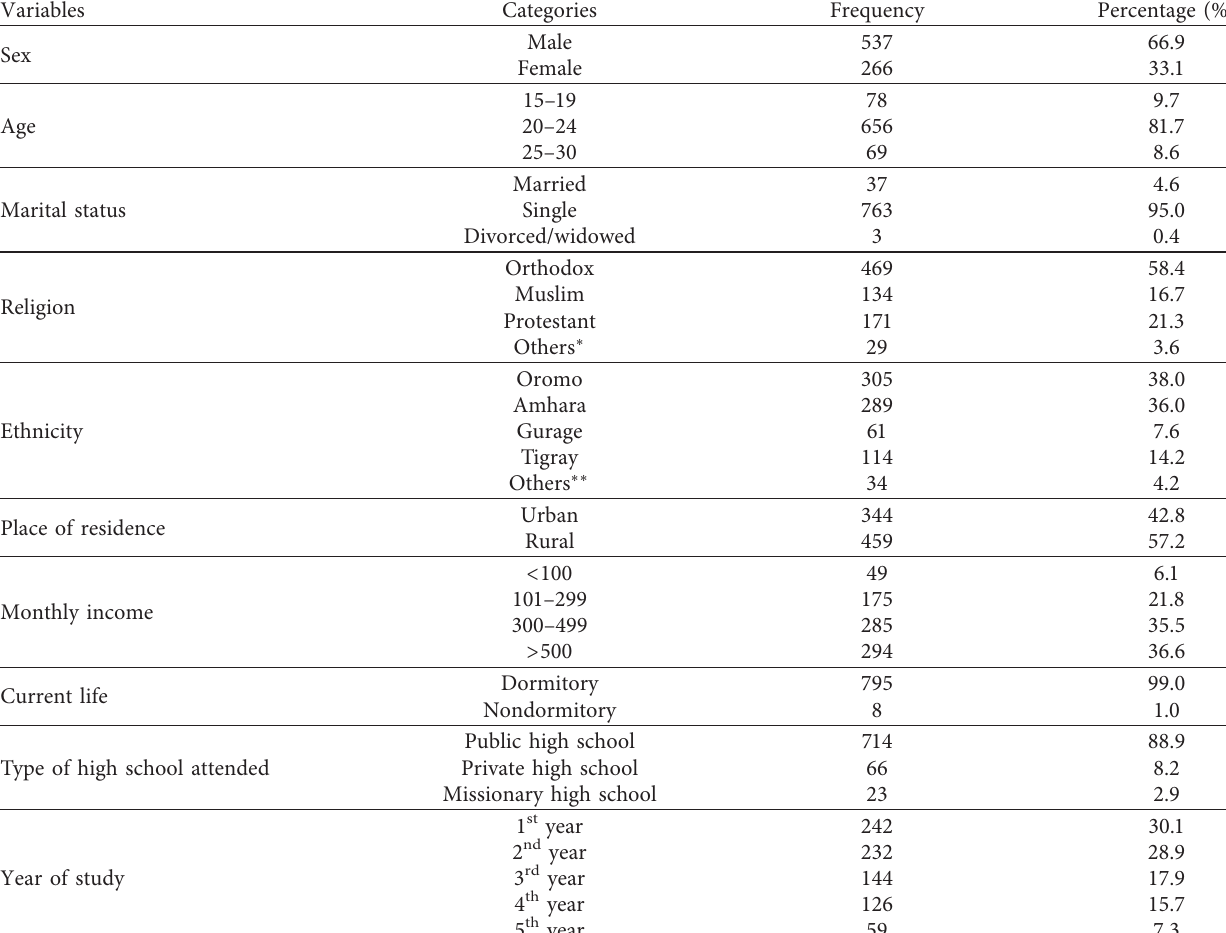
Table 1: Sociodemographic characteristics of respondents at Dilla University, SNNPR, Ethiopia, 2018.